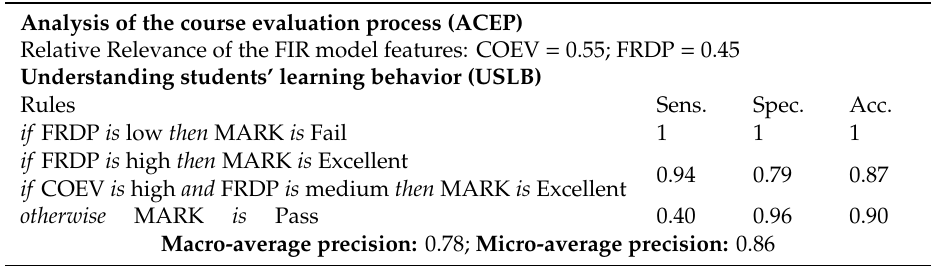
Table 10. ACEP, USLB, ASLP, and GSLB toolbox results for the model 4 of the introductory course. The MARK variable was discretized into three classes: fail (from 0–60), pass (from 61–80), and excellent (from 81–100). COEV was discretized into three classes: low (from 0–6), medium (from 6.1–8.9), and high (from 9–10). FRDP was discretized into three classes: low (from 0–20), medium (from 21–30), and high (from 31–40). Spec., Sen., and Acc. stand for specificity, sensitivity, and accuracy,